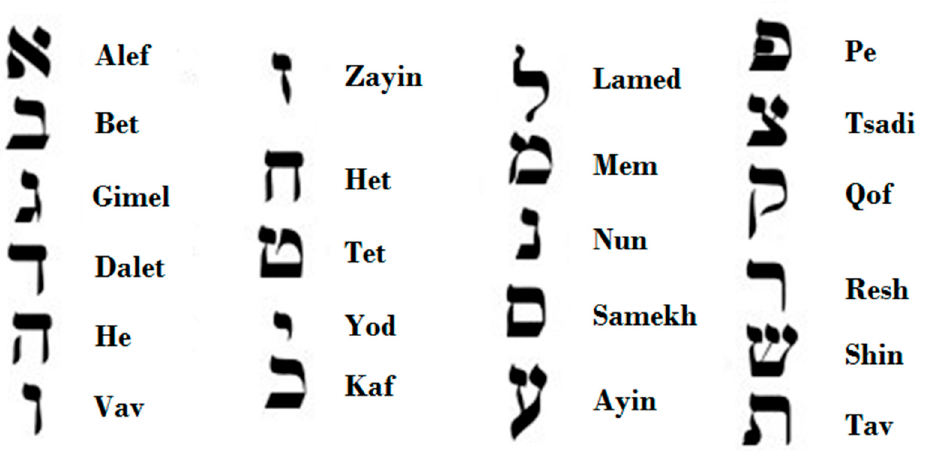
Figure 11. Hebrew alphabet.